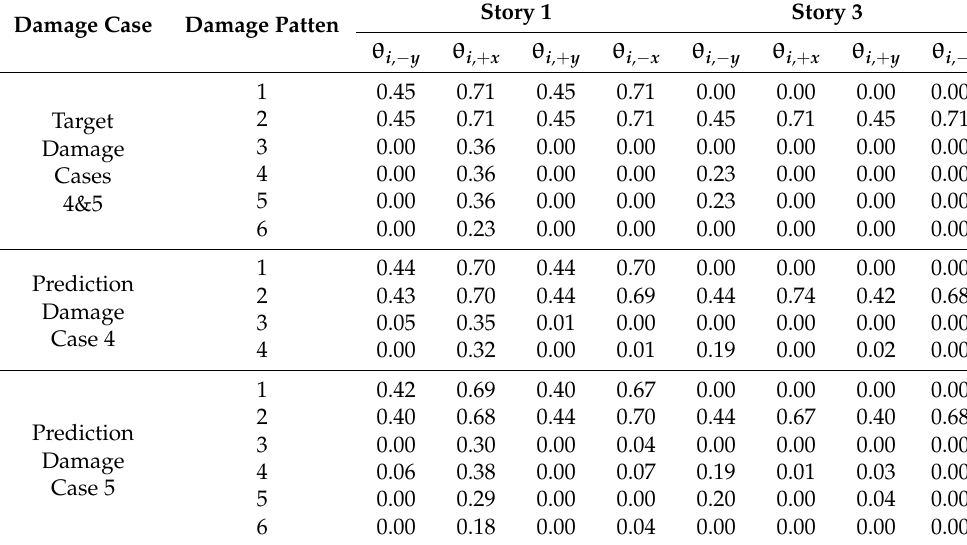
Table 5. Estimates of Damage Severities for Damage Cases 4–5 (DMI). Damage